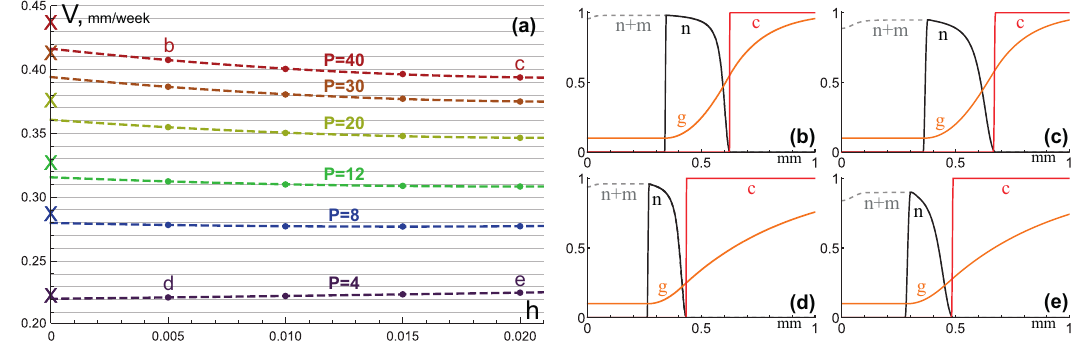
Figure 2. ( a ) The dots denote the values of tumor growth speed V , obtained numerically in the simulations of Equation (1) under designated values of angiogenesis parameter P and space step h , with time step τ = h 2 , D n = 0, R = M = 0.1/ τ , (cid:101) = 10 5 and the values of other parameters taken from the basic set. The dashed lines represent the best fit quadratic functions for every value of P . The crosses on the vertical axis mark the analytically derived values of tumor growth speed for the values of P used. ( b – e ) The distributions of the model variables on the 20th day of simulations under the values of the parameters, designated by the corresponding letters in ( a